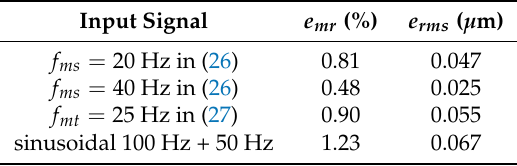
Figure 5. Validation results of the identified hysteresis model under the signal which is the sum of 2 different sinusoidal profiles with 100 Hz and 50 Hz frequencies. Table 2. Output errors of the model